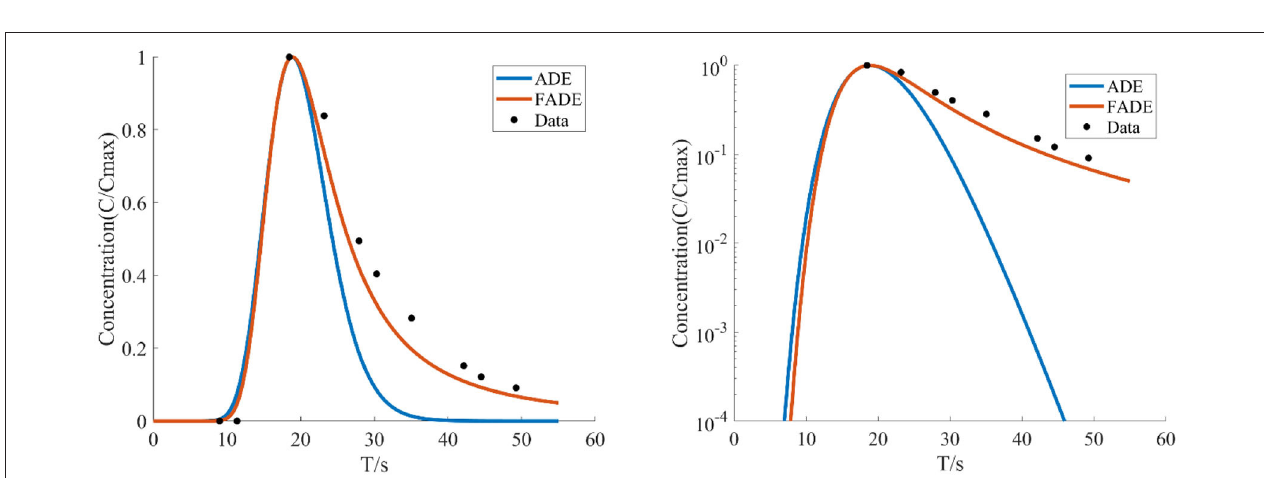
FIGURE 10 | With the average flow velocity v = 23.3541 mm/s, the average fracture width is e = 4.9mm, the concentration of the relative roughness 1 /e is 0.2041 test data, the BTCs are fitted by ADE model and FADE model.